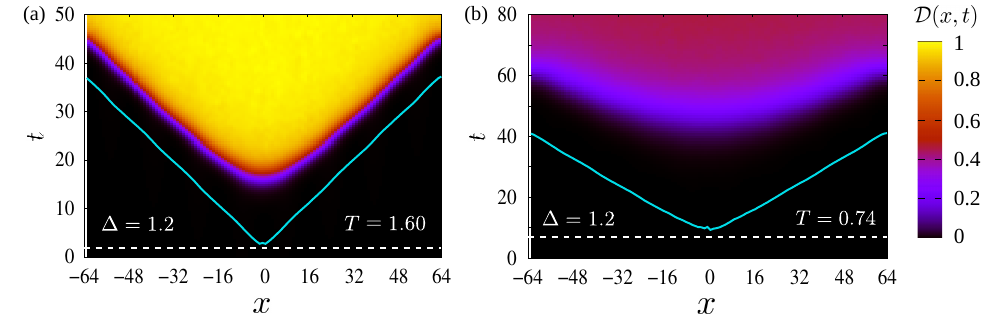
Figure 10: OTOC and ballistic light cone for easy-axis anistropy: D ( x , t ) at (a) T = 1.60 ( T > T ) and (b) T = 0.74 ( T < T ), for ∆ = 1.2. The solid lines are the c c ( x , t ) = 0, and the horizontal dashed lines denote light cones from extracted from λ L the delay time t 0